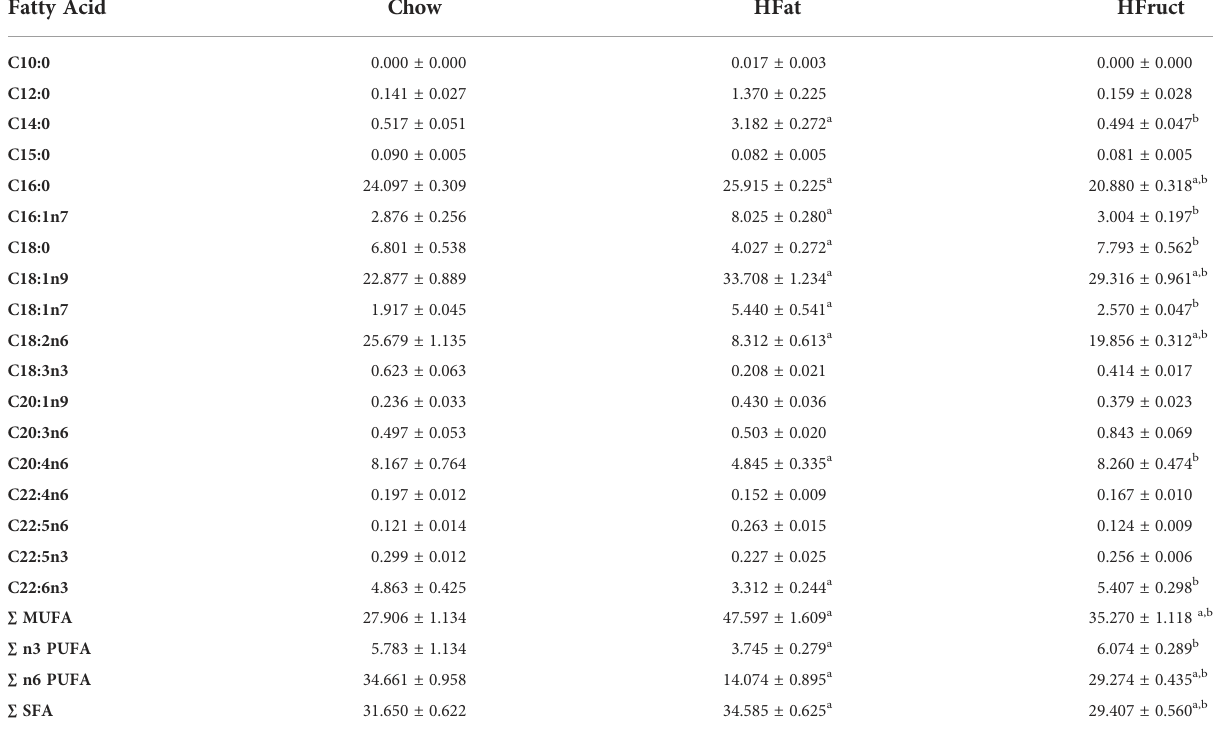
TABLE 1 Fatty acid composition of liver tissue obtained from normal chow diet (Chow), high-fat diet (HFat), and high-fructose (HFruct)-fed male C57Bl6/J mice after 12 weeks of diet. Chow